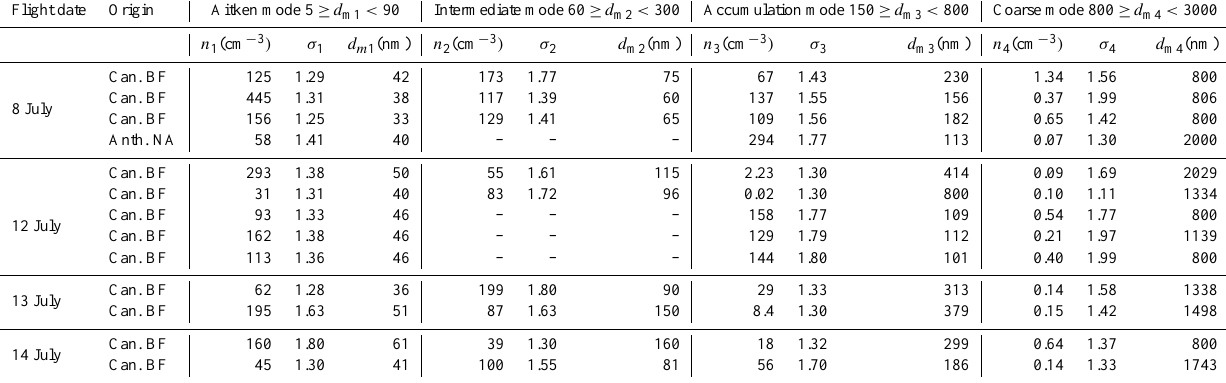
Table 3. Log-normally fitted size distribution parameters for the 13 selected time windows. Flight date Origin